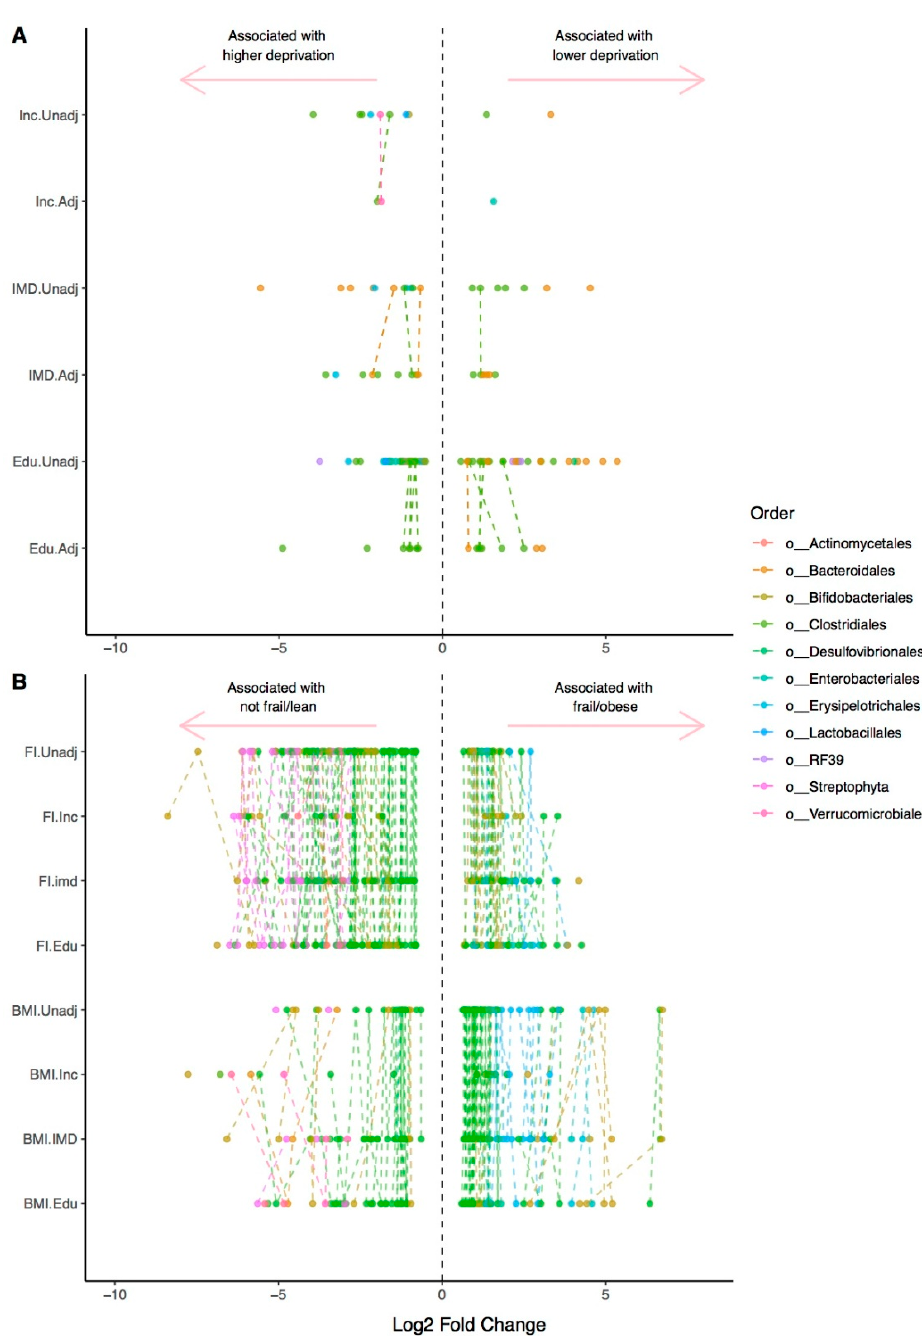
Figure 2. Differential abundance of OTUs with socioeconomic variables and covariates. DeSeq2 was used to calculate the differential abundance of OTUs in: ( A ). Between the lowest and highest levels of deprivation for education, income and the IMD, and in models adjusted for age, Body Mass Index (BMI), health deficit (FI) and diet (HEI); ( B ). Between lowest and highest levels of BMI and health deficit (FI), and in models adjusted for education (Edu), income (inc) and the Index of Multiple deprivation (imd). The phyla assigned to each denovo OTU is indicated. Dashed lines connect the same OTU ids in each hierarchical model; therefore, where there are no connecting lines, the associate was not observed in the corresponding model..